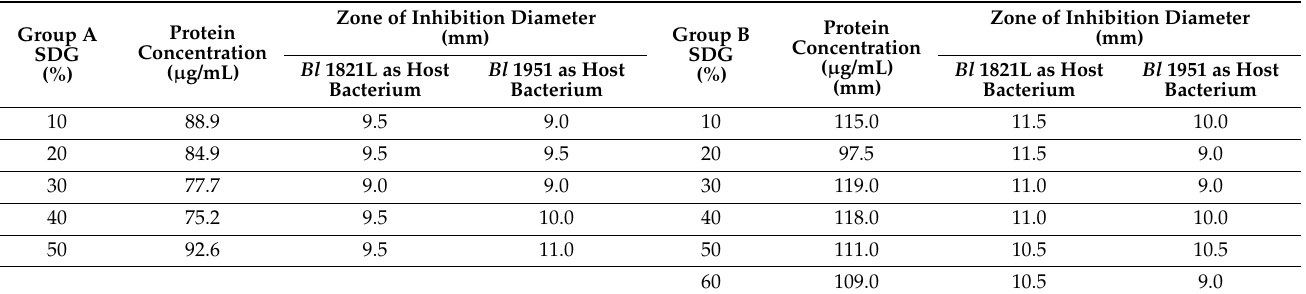
Table 4. Bl 1951 putative antibacterial protein assay test and quantification using group A (10–50%) and group B (10–60%) SDGs.